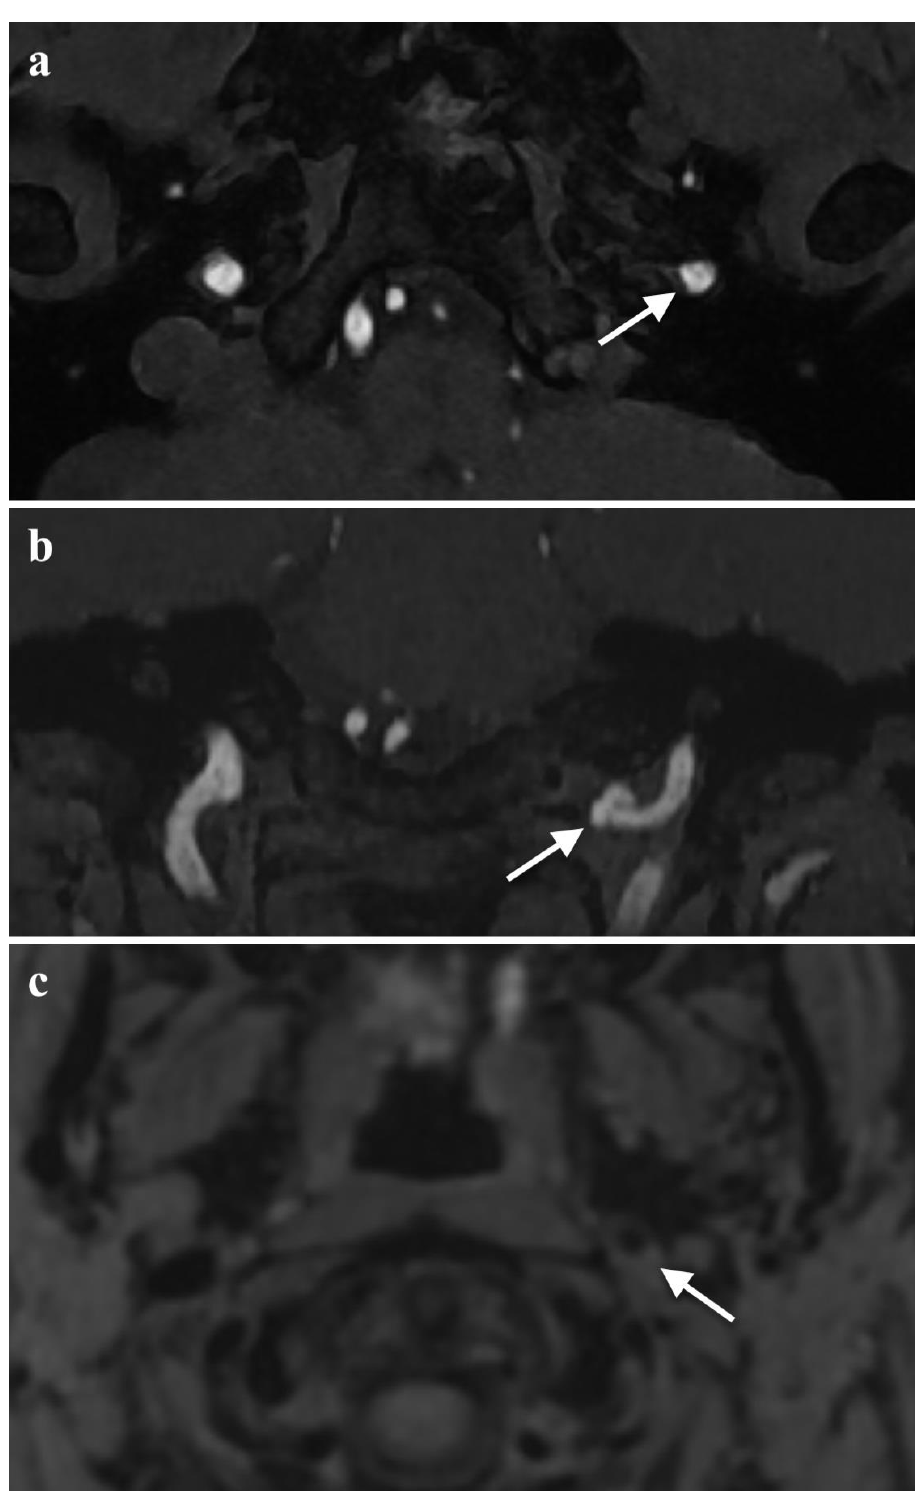
Figure 5. Follow-up MRA of the head arteries: ( a ) follow-up TOF MRA at the level of the carotid canal entrance showing the resolution of the left ICA stenosis (arrow); ( b ) follow-up TOF MRA demonstrating the reduction in the size of the left ICA false aneurysm (arrow); ( c ) fat saturated T1-weighted image showing small residual intramural thrombus in the left ICA